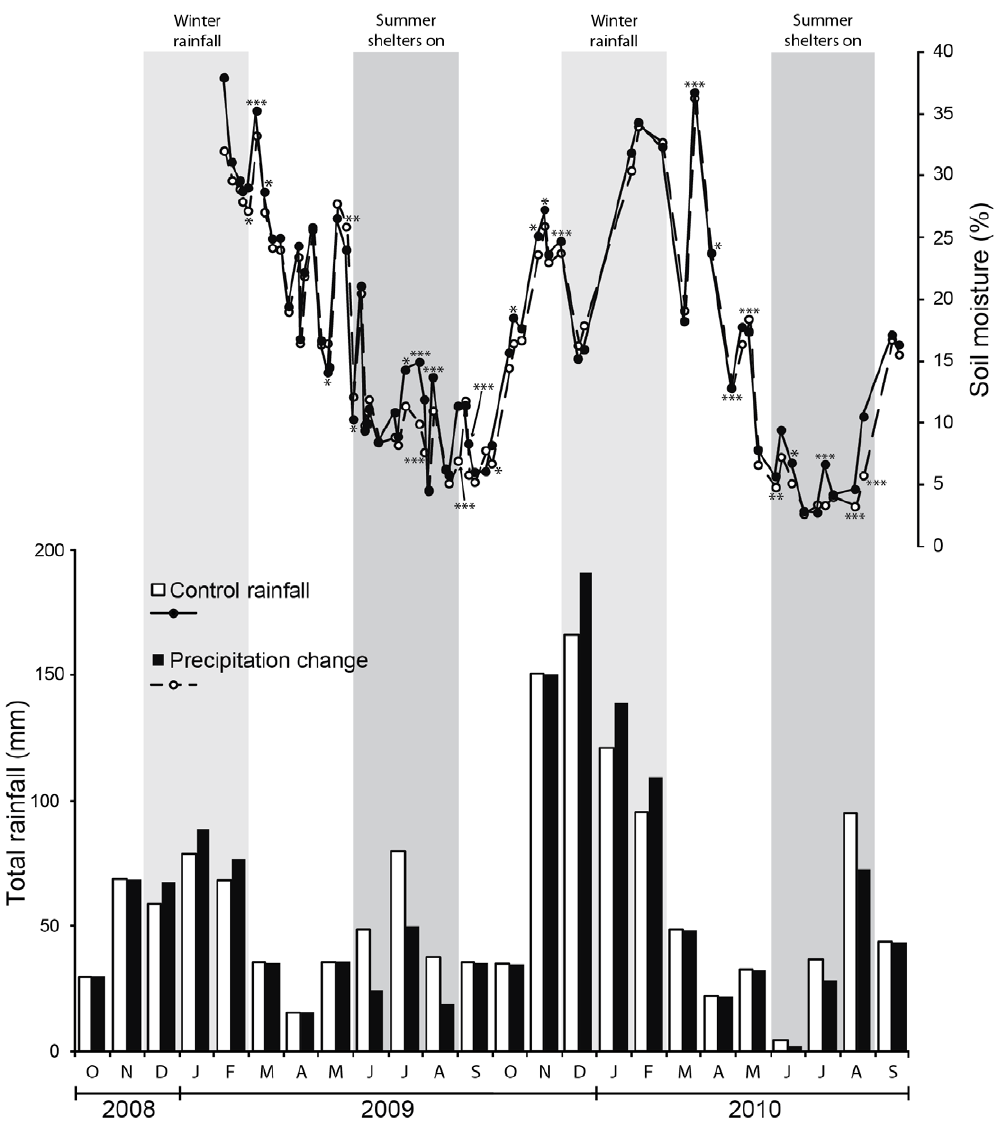
Figure 1. Rainfall applied to treatments during the measurement period of the experiment. Significant differences in soil moisture between precipitation treatments are represented by asterisks *=p , 0.05, **=p , 0.01, ***=p , 0.001.